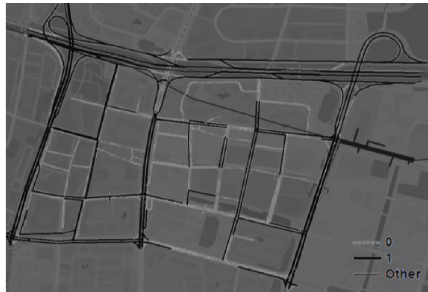
Figure 3: Space coverage of floating car data at the 40th